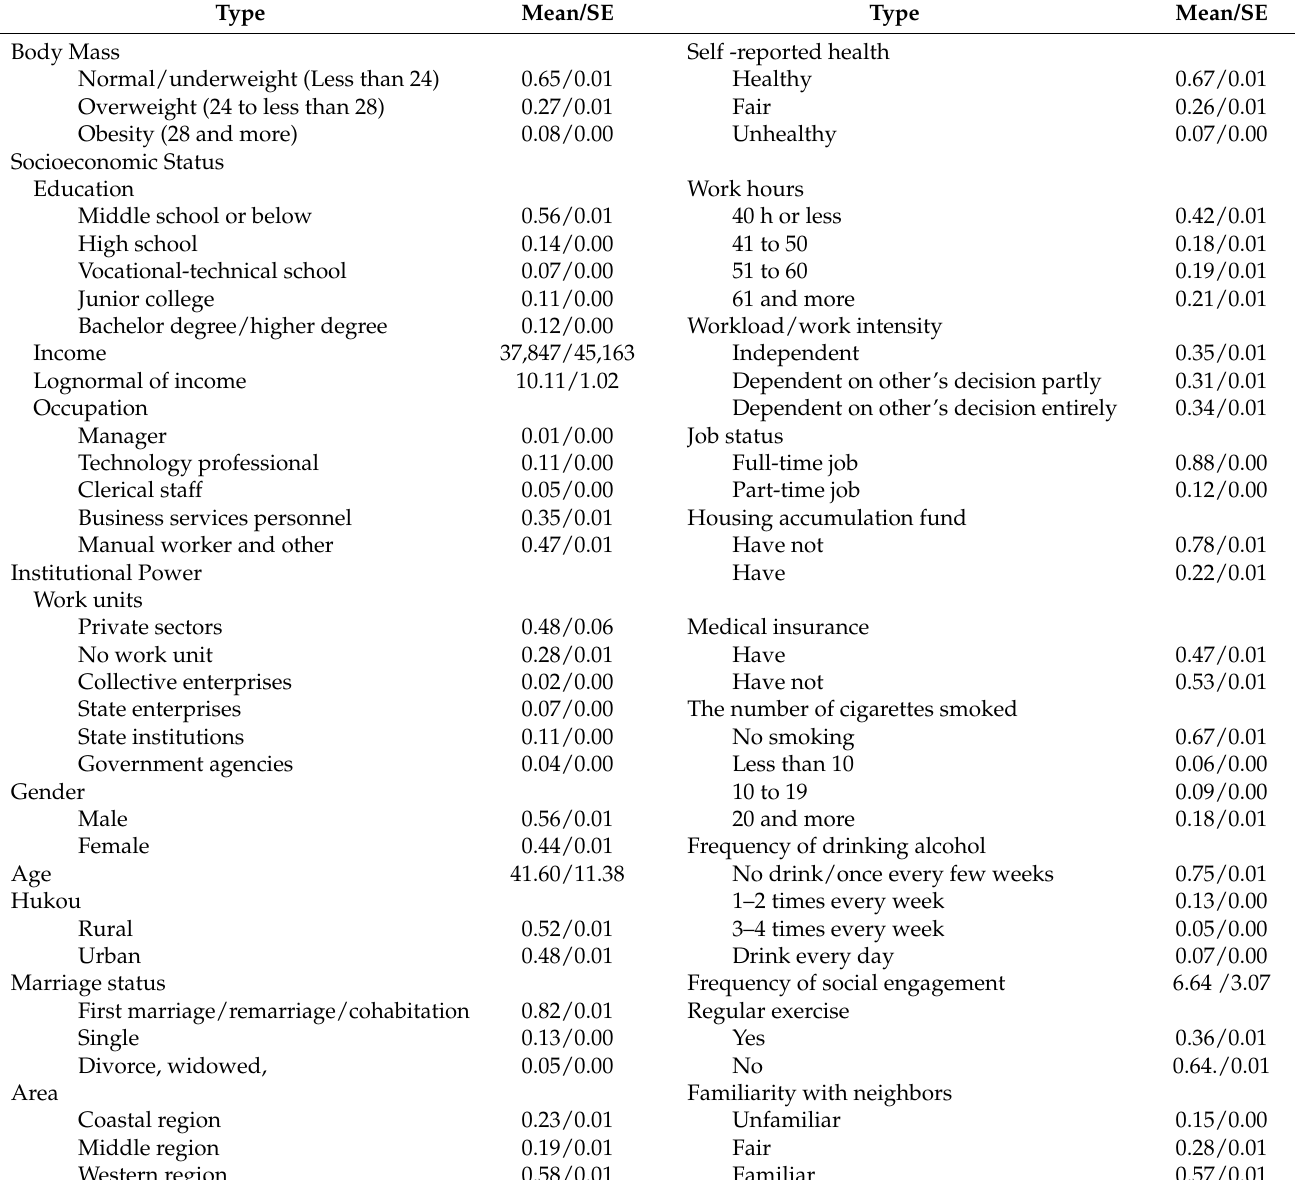
Table 1. Descriptive statistics for variables used in analysis of BMI (N =